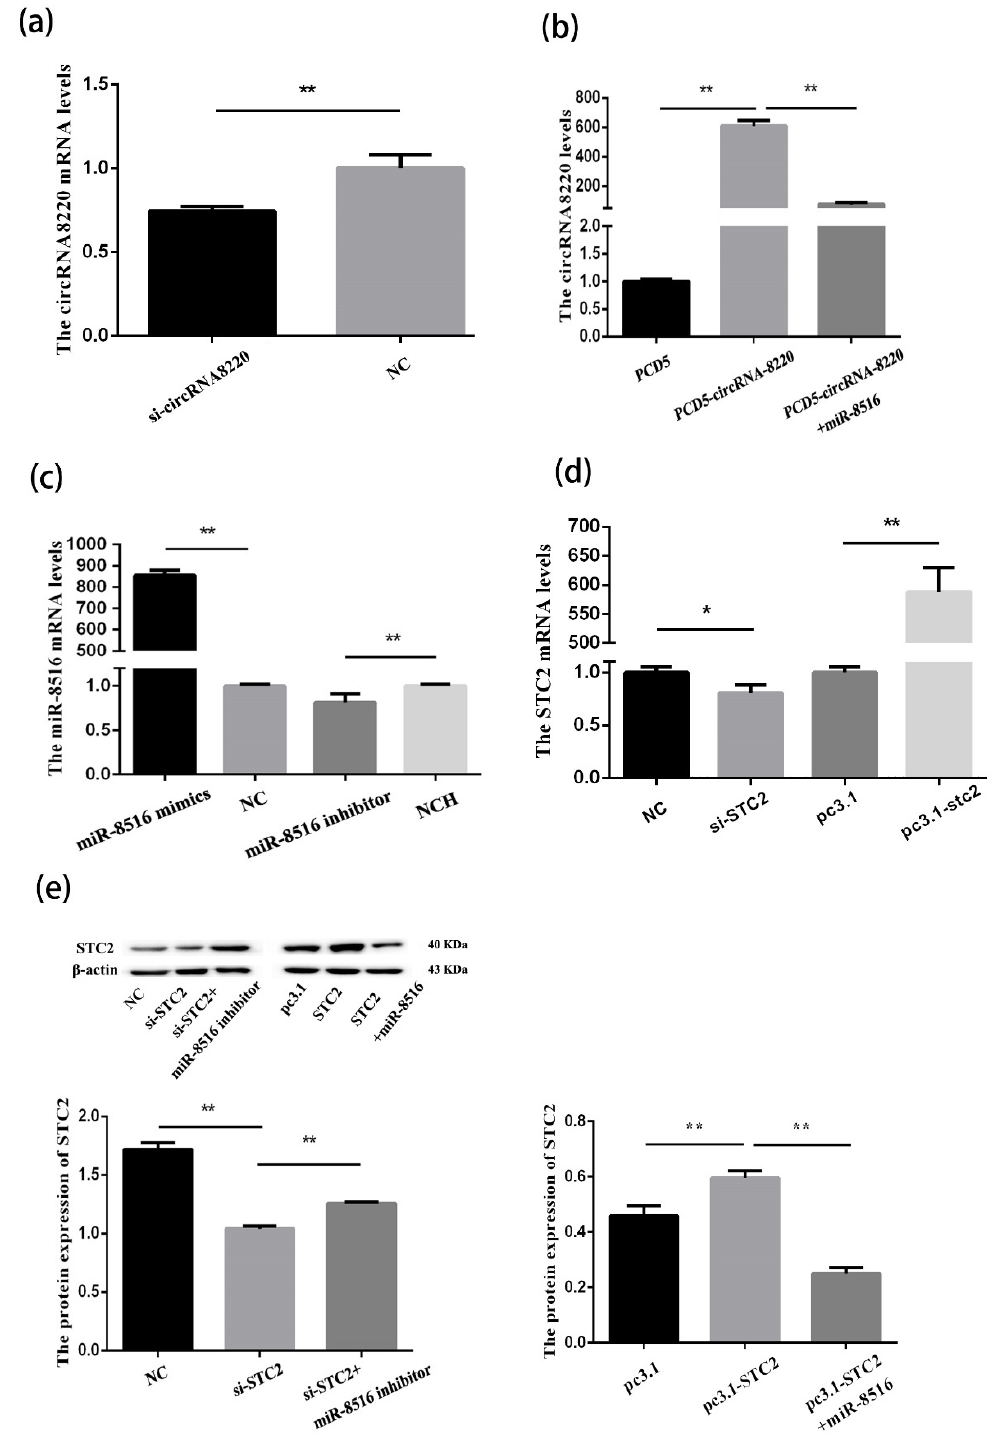
Figure A1. Transfection e ffi ciency of pcDNA3.1-STC2 and pCD5-circRNA8220 vectors and STC2-siRNA, circRNA8220-siRNA and miR-8516 mimics / inhibitors. ( a , b ) mRNA levels of circRNA8220. ( c ) mRNA levels of miR-8516. ( d ) The mRNA levels of STC2. ( e ) Protein levels of STC2. ** p < 0.01, * p <